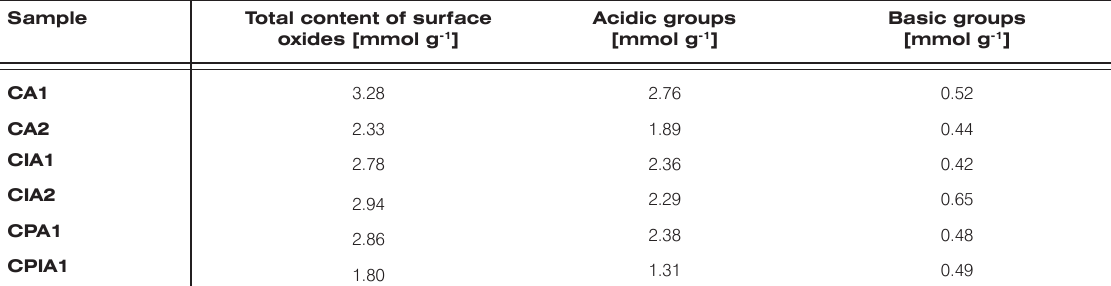
Figure 1. Nitrogen adsorption isotherms of the activated carbons obtained. Table 4. Acid-base properties of obtained activated